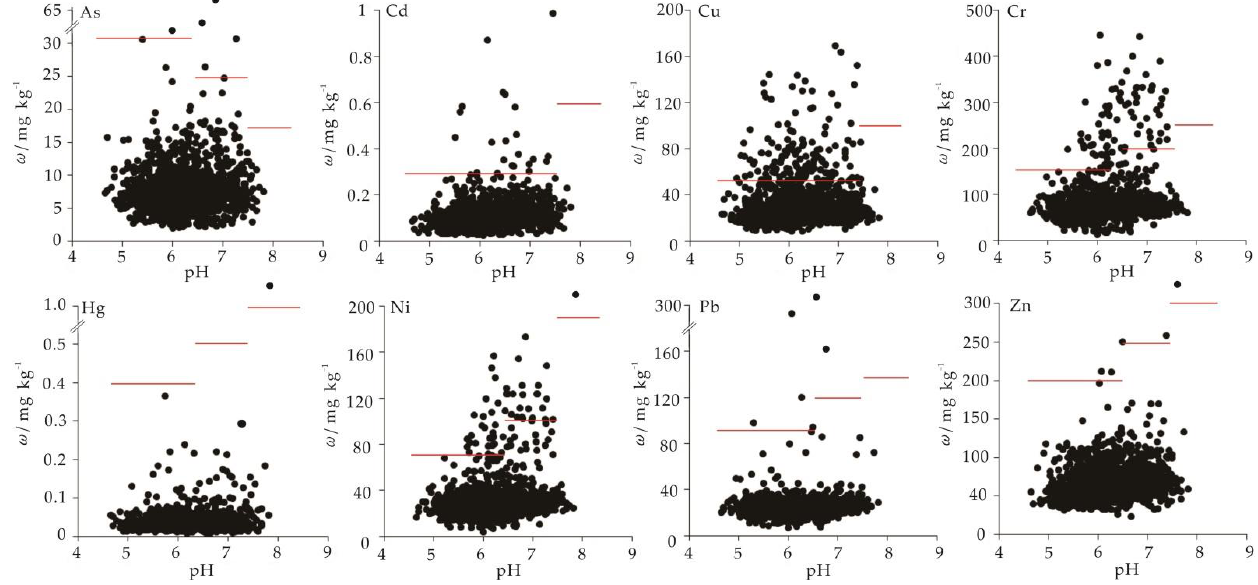
Figure 2. Relationships between soil heavy metal contents and pH. Note: The red line represents the risk screening value corresponding to different pH values.